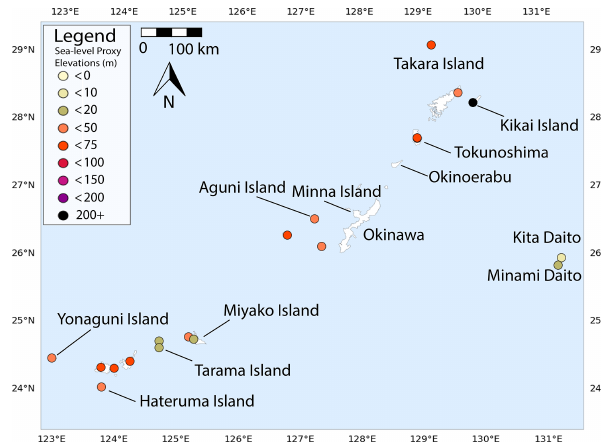
Figure 11. Sea-level elevation proxies in the Ryukyu Islands. Sea- level indicators (circles) with elevation range indicated by color (see